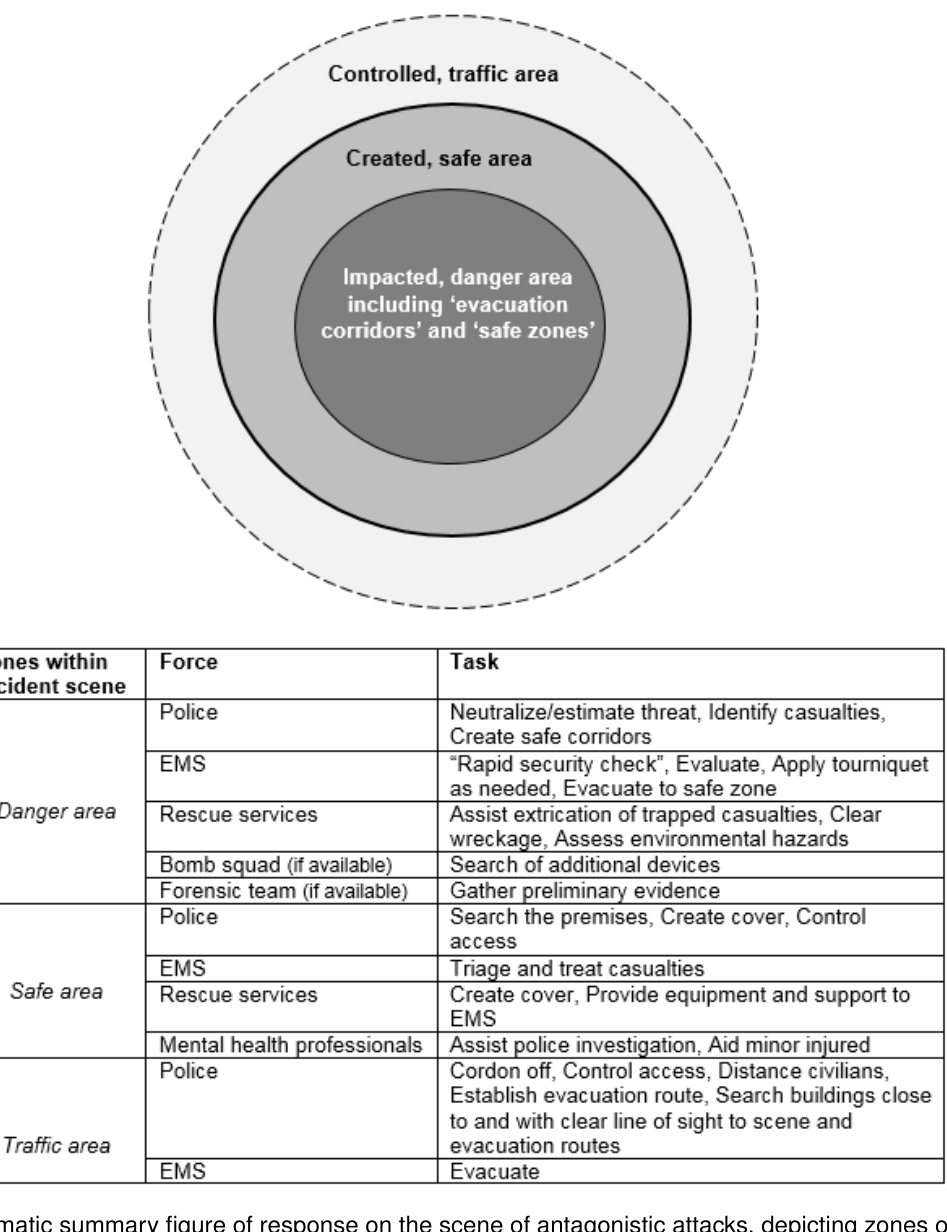
Figure 3. Schematic summary figure of response on the scene of antagonistic attacks, depicting zones of action and essential tasks by personnel of the responder forces (adapted from Almogy & Rivkind 2007 [34], Jacobs et al. 2014 [29]; Autrey et al. 2014